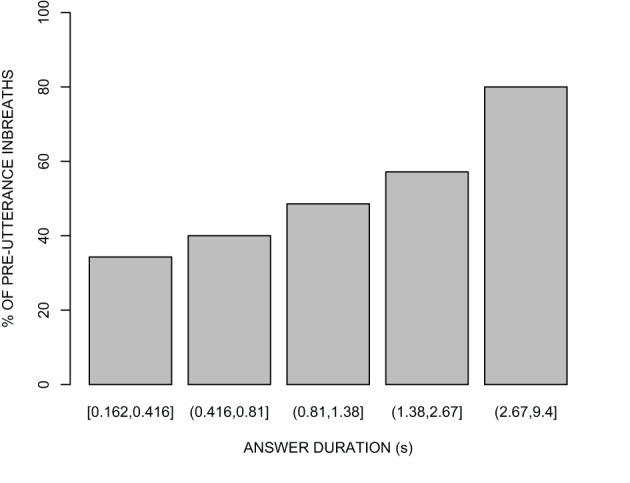
Percentage of pre-utterance inbreaths as a function of answer duration (s) for five quantiles of approximately equal size (n = 35 for the lowest quantile, and n = 34 for all other quantiles).